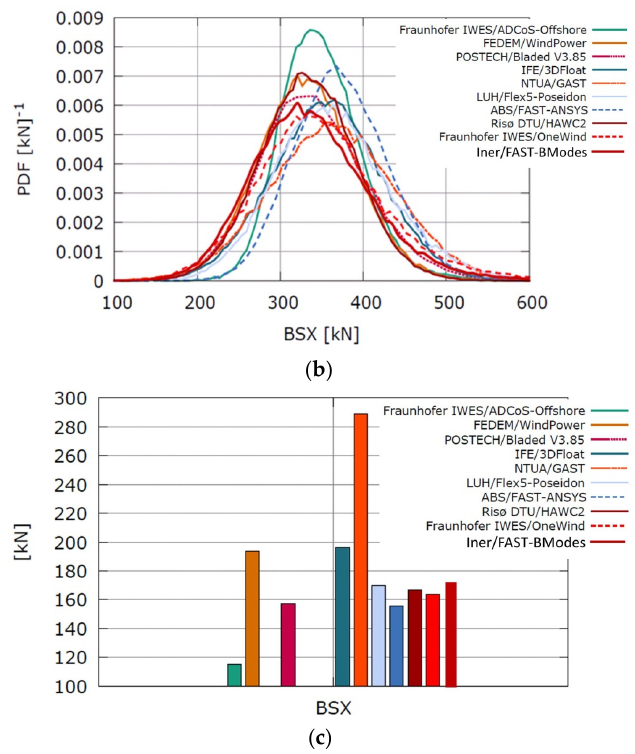
Figure 12. Analysis Results for Load Case 2.4b of OC4 Phase I. ( a ) PDF_Tower ‐ Top Fore ‐ Aft Shear Force; ( b ) PDF_Fore ‐ Aft Shear Force at Mudline; ( c ) DEL_Fore ‐ Aft Shear Force at Mudline. PDF: Power Density Function; BSX: Fore ‐ Aft Shear Force at Mudline; DEL: Damage Equivalent Load.